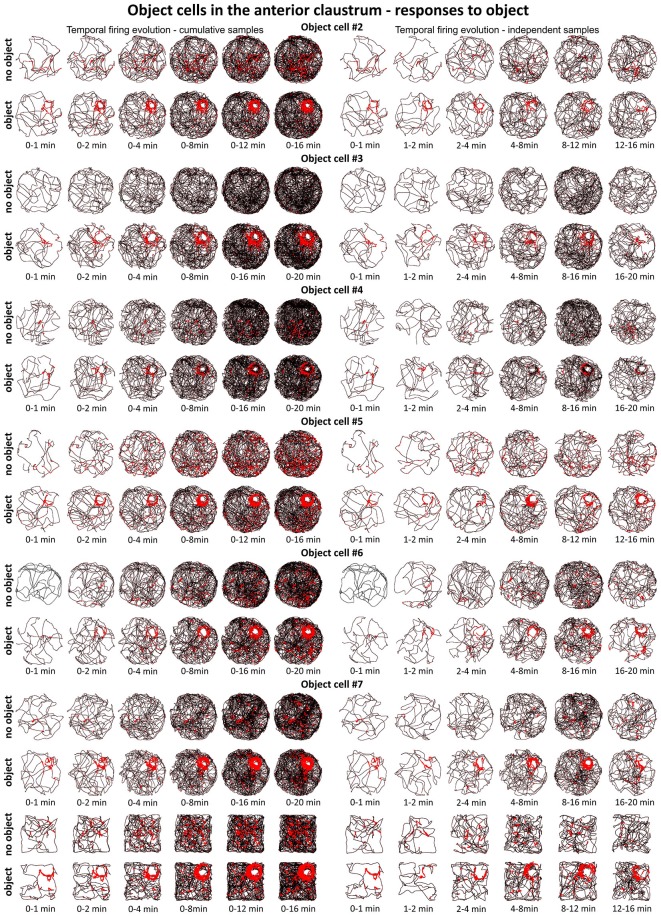
Temporal evolution of firing of claustral object cells #2–#7 presented in Figures 3 and 4. For each cell are shown two consecutive recording sessions with and without presentation of the object (glass bottle). For cell #7, additional recordings performed in the square arena are presented. On the left, six samples of cumulative time intervals, and on the right, six samples of independent time intervals are presented in rows for each cell. Sessions were 16 or 20 min long. Object cells responded throughout the whole session from the beginning until the end of the session (cell #3 had an exceptionally low spontaneous firing rate without the object). The visual cue was located in the same place as in Figure 1 in baseline conditions.